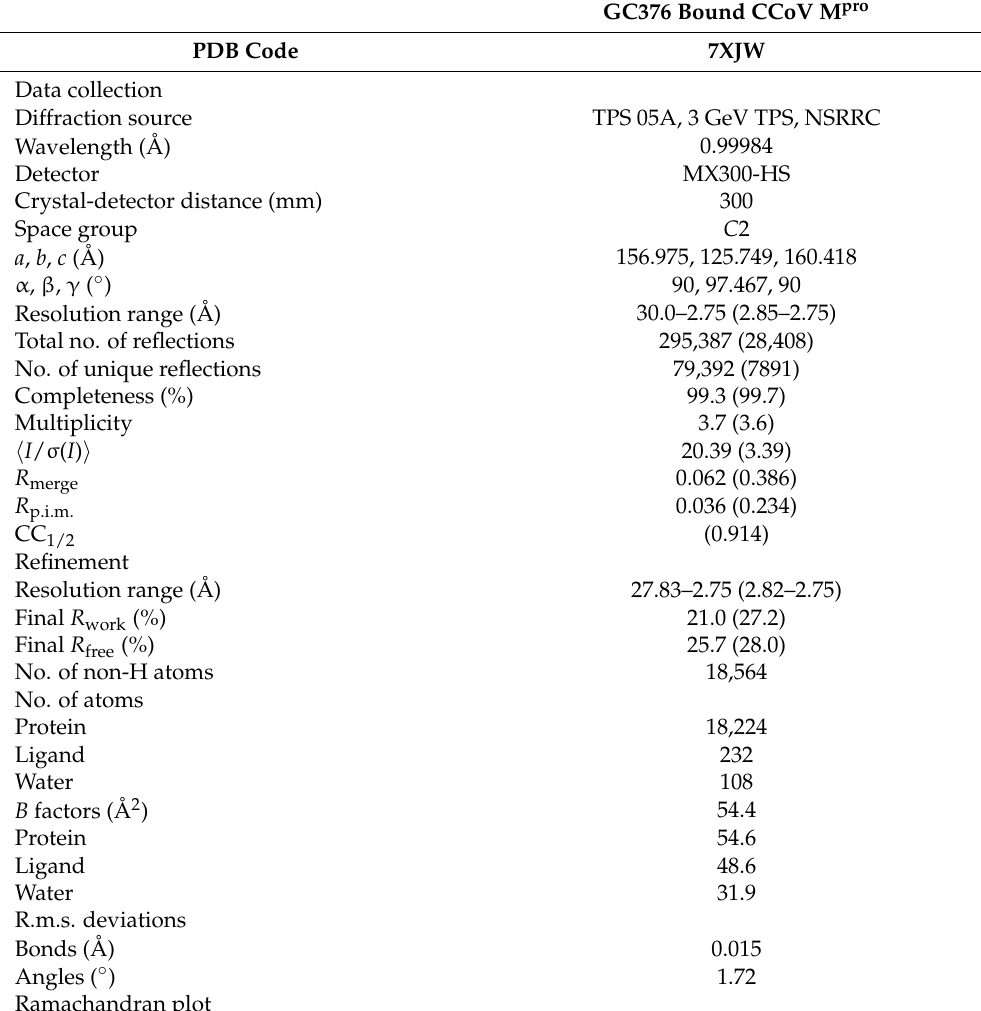
Table 1. X-ray data collection and refinement statistics of GC376 bound CCoV M pro